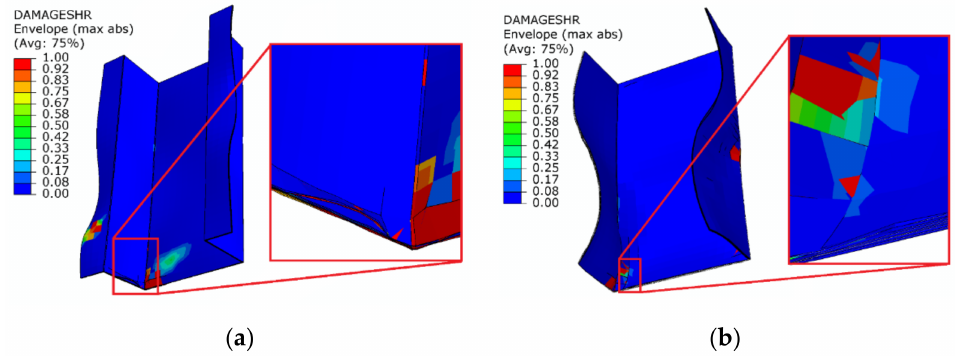
Figure 12. Additional delamination regions observed in numerical simulation: ( a ) top-hat column; ( b ) channel